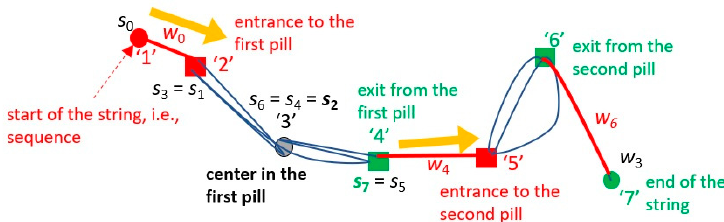
Figure 2. Tangled string TS applied for String . s i is the i -th event in the sequence, corresponding to the token “ x ” beside it.